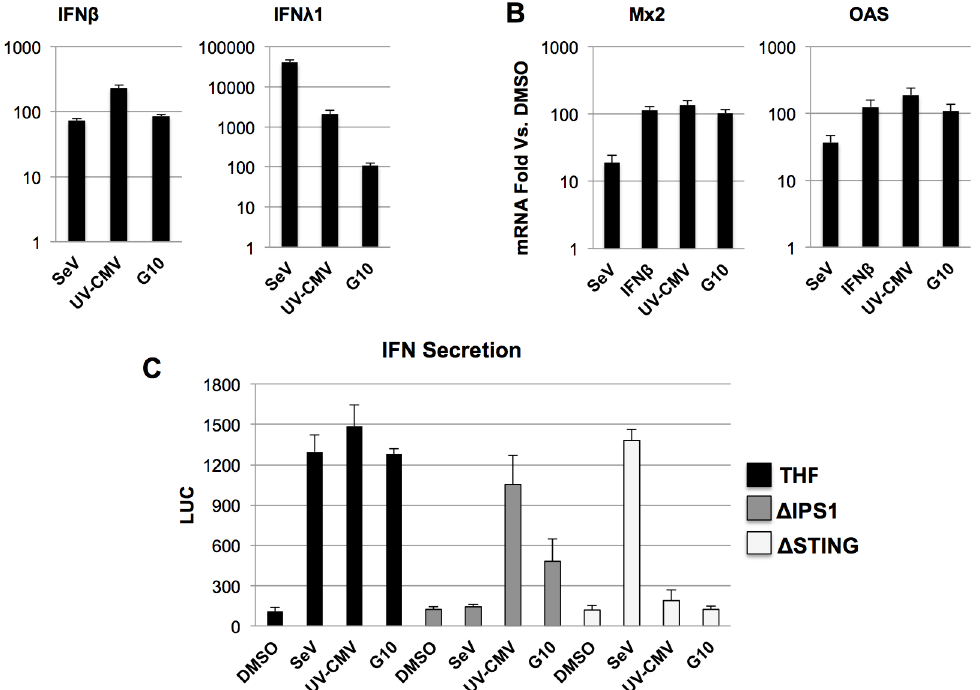
Fig 7. G10-Mediated Expression of Type I and III IFN and IFN-Dependent Genes. Induction of IFN β and IFN λ 1 ( A ) or Mx2 and OAS ( B ) transcripts in THF following 18h exposure to SeV, UV-CMV, or 100 μ M G10 or IFN β as indicated. Values presented are average fold changes relative to cells treated with 1% DMSO ± SD based on duplicate treatments. (C) Secretion of type I IFN from THF-ISRE, THF-ISRE- Δ IPS1, or THF-ISRE- Δ STING following 18h exposure to 1% DMSO, SeV, UV-CMV, or 100 μ M G10. Average LUC values ± SD were obtained from THF-ISRE- Δ IRF3 exposed (in triplicate) to media harvested from indicated cells and exposed to indicated stimulus (in